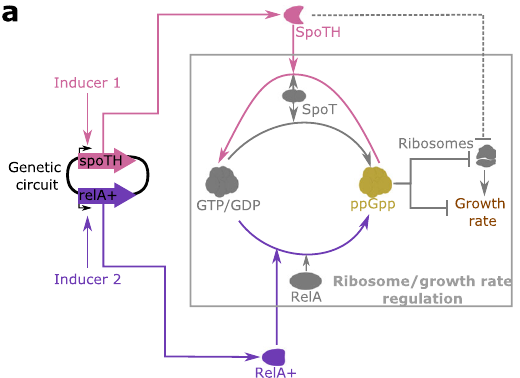
Fig. 1 | Growth rate actuation via SpoTH and RelA+. a Diagram of the circuit describinghowSpoTHandRelA+expressionaffectribosomesandgrowthrate.The nucleotide ppGpp negatively regulates ribosome production and growth rate in E. coliduringexponentialgrowth.ThesynthesisofppGppiscatalyzedfromGTP/GDP bybothRelAandSpoT,whilethehydrolysisofppGppiscatalyzedbySpoTonly 39 – 41 . A modi fi ed version of SpoT with only hydrolysis activity (SpoTH) catalyzes the hydrolysis of ppGpp 43 . A modi fi ed version of RelA containing the N-terminal 455 residues of RelA (RelA+) catalyzes the synthesis of ppGpp 33,34,64 . Both SpoTH and